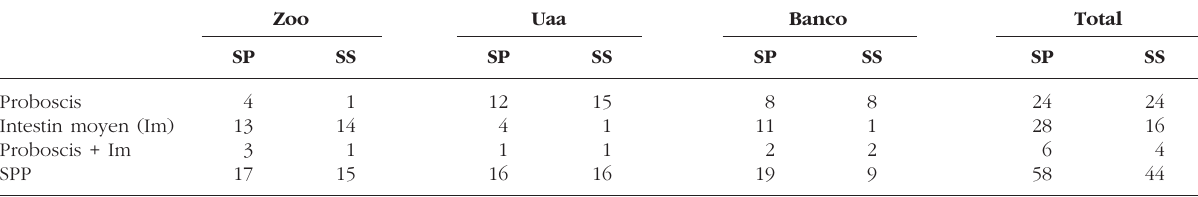
Tableau II. – Répartition des femelles disséquées par groupes et par période de capture selon les saisons.